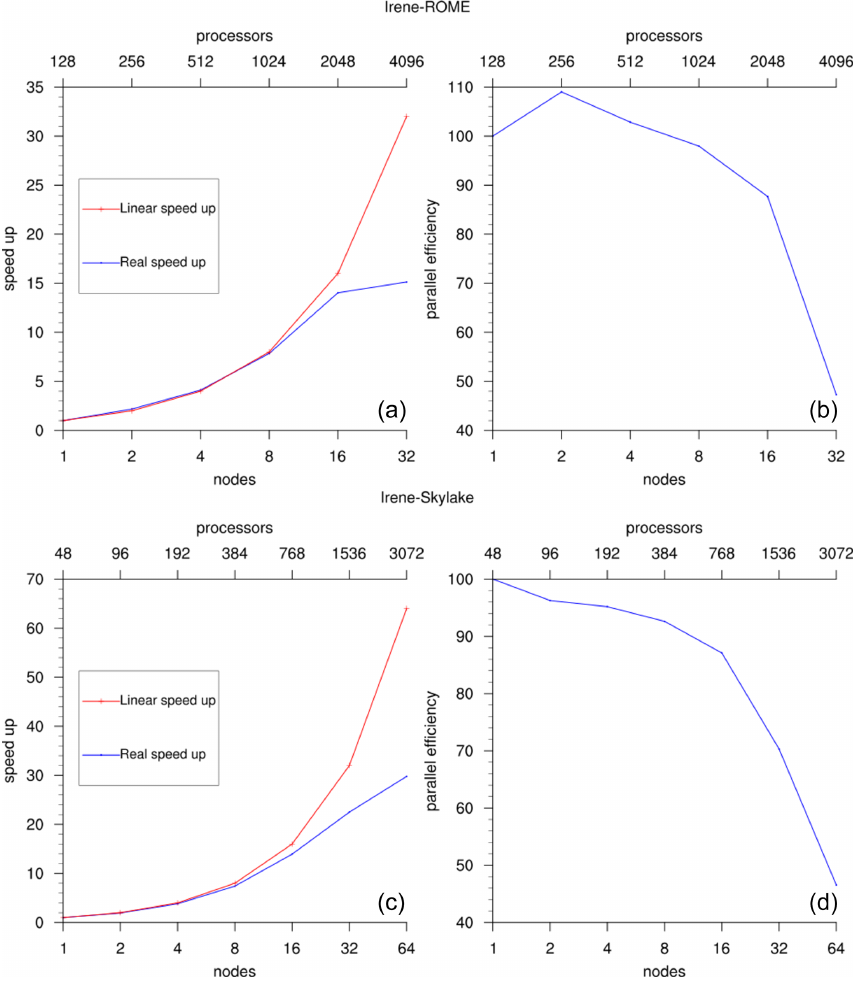
Figure C1. Strong scalability analysis (time to solution). (a, b) Speedup and parallel efficiency analysis at Irene ROME (128 AMD processors per node). (c, d) Same for Irene Skylake (48 Skylake processors per